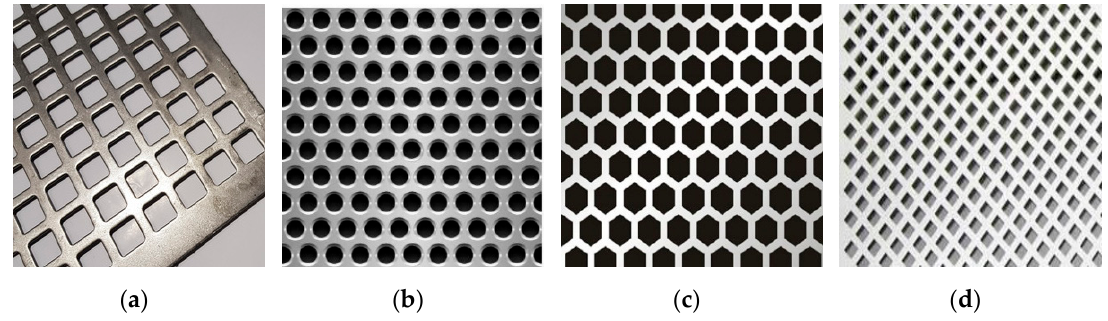
Figure 1. Some shapes of perforated steel sheets are used in structures such as ( a ) Square, ( b ) Circular, ( c ) Hexagonal and ( d ) Rhombus.